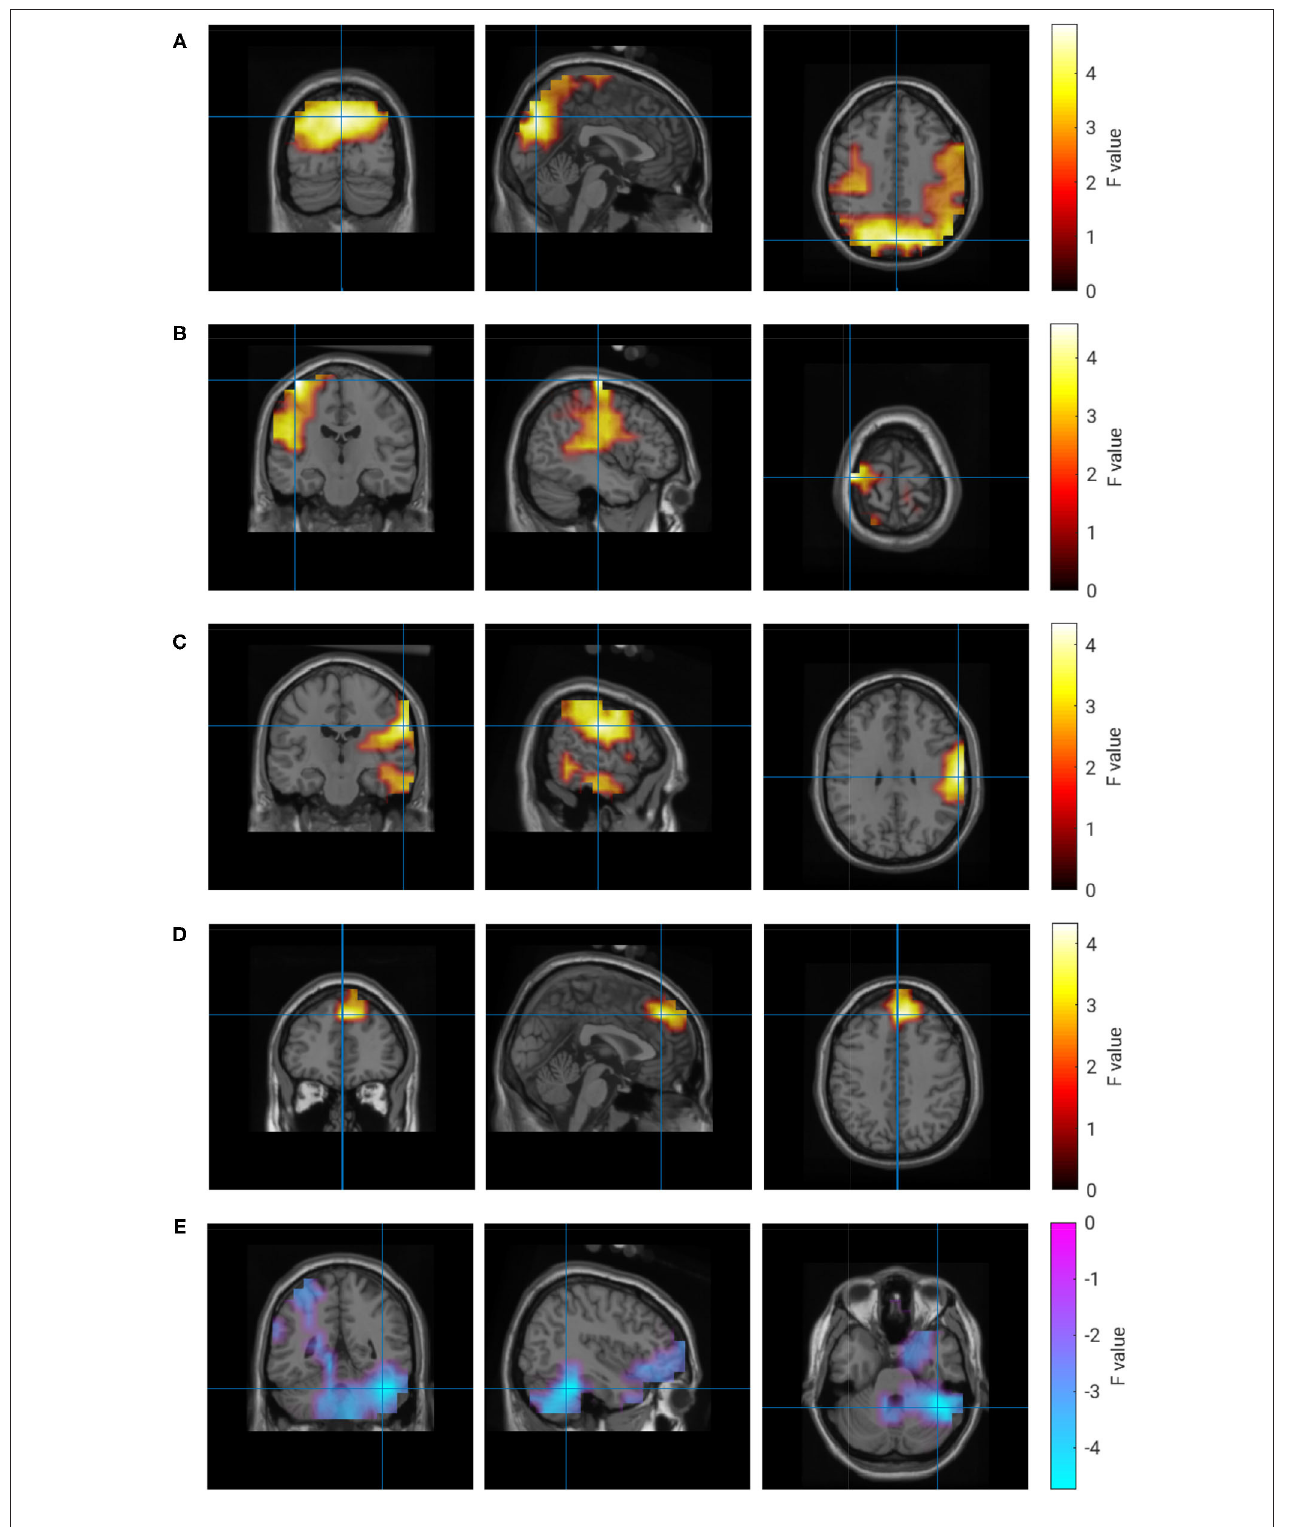
FIGURE 6 | Correlation of brain activity and rating of own performance. (A) 10 Hz, (B) 25 Hz, (C) 22 Hz, (D) 22 Hz, (E) 1 Hz.